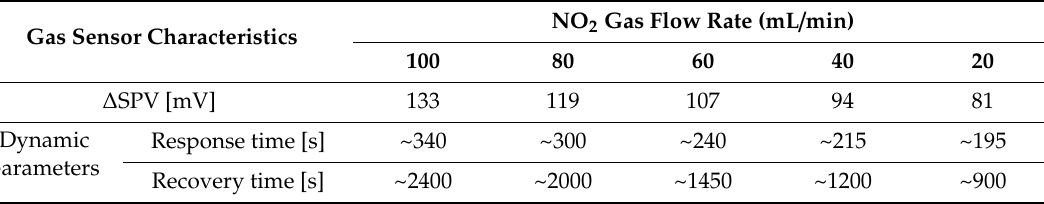
Table 1. Variation in the SPV signal at various NO 2 gas flow rates at constant 20 ppm relative concentration, together with the basic dynamic